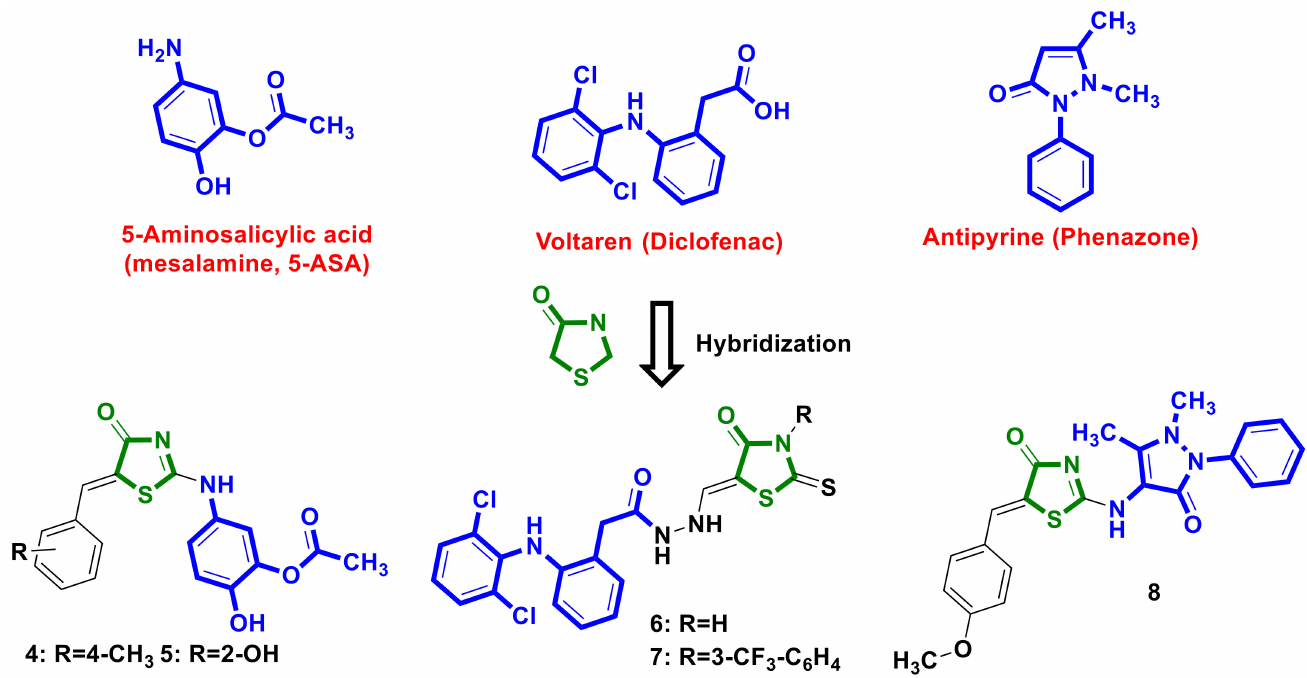
Figure 3. 4-Thiazolidinone-bearing hybrids molecules with NSAIDs scaffolds possessing anticancer